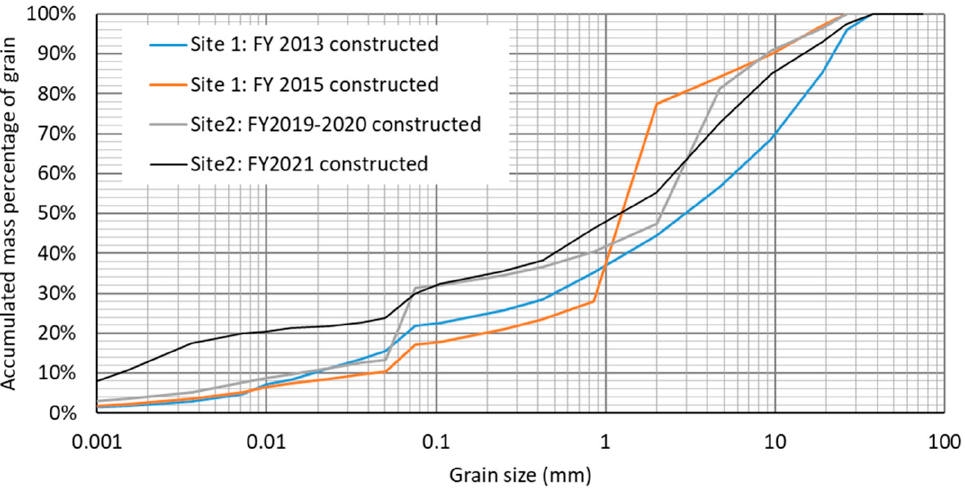
Figure 8. Grain size distribution of soil sampled at Sites 1 and 2.